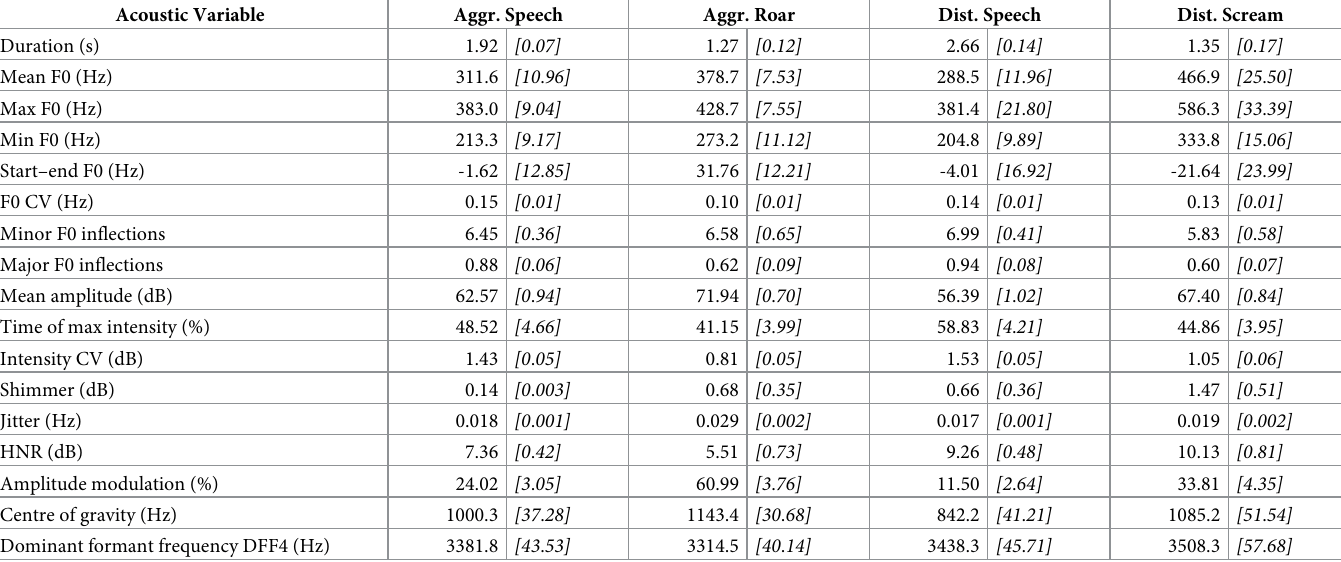
Table 1. Mean acoustic characteristics of male vocal stimuli. Figures in square brackets represent standard errors. Acoustic Variable